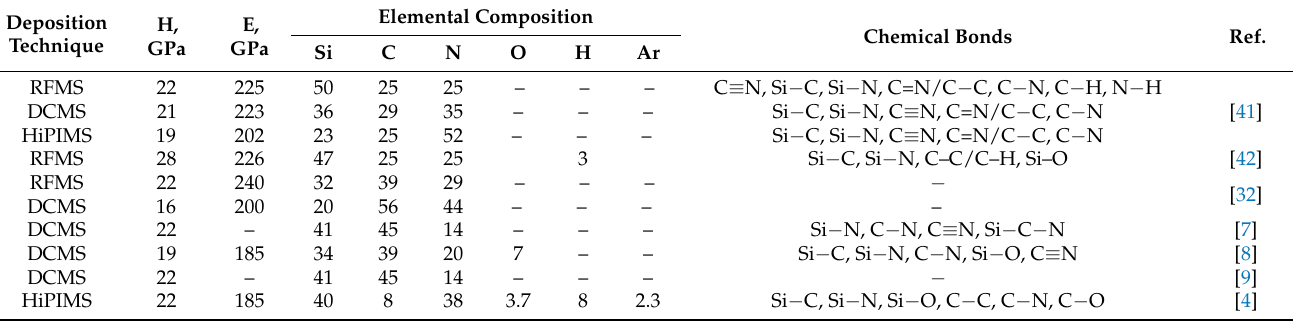
Table 2. Mechanical properties and composition of SiC x N y films obtained by magnetron